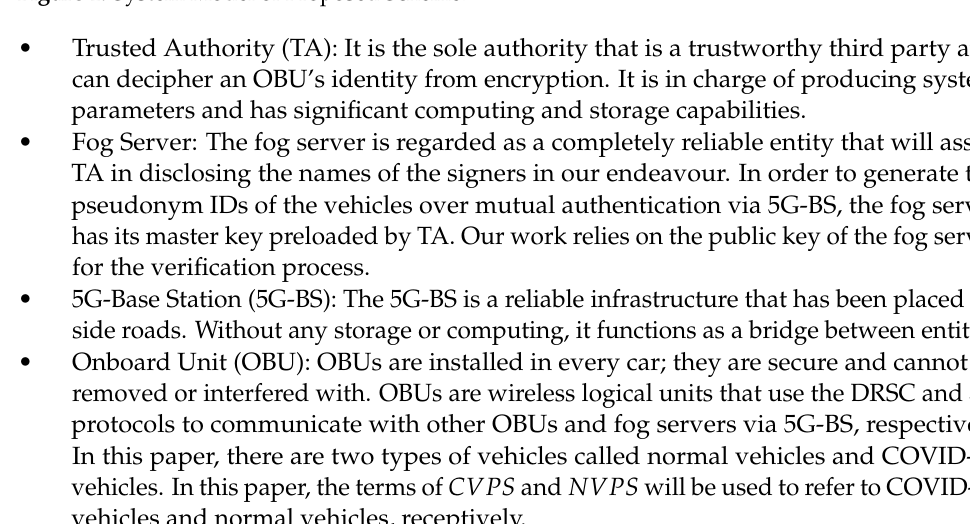
Figure 1. System Model of Proposed